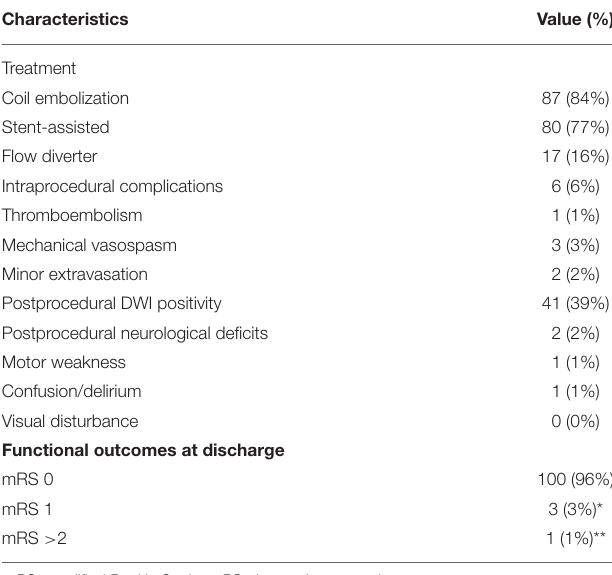
TABLE 2 | Endovascular aneurysm treatment and clinical